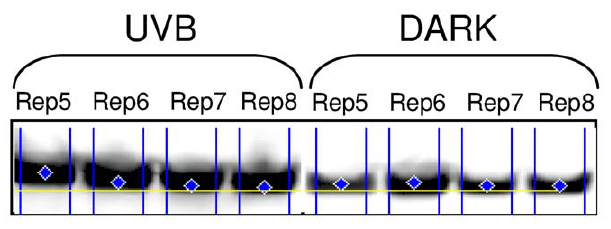
Figure 5. Detection of the RecA protein ( < 40 kDa) by quantitative fluorescent western blot analysis of both UVB- treated cells and dark control cultures. Four different biological replicates are shown for each